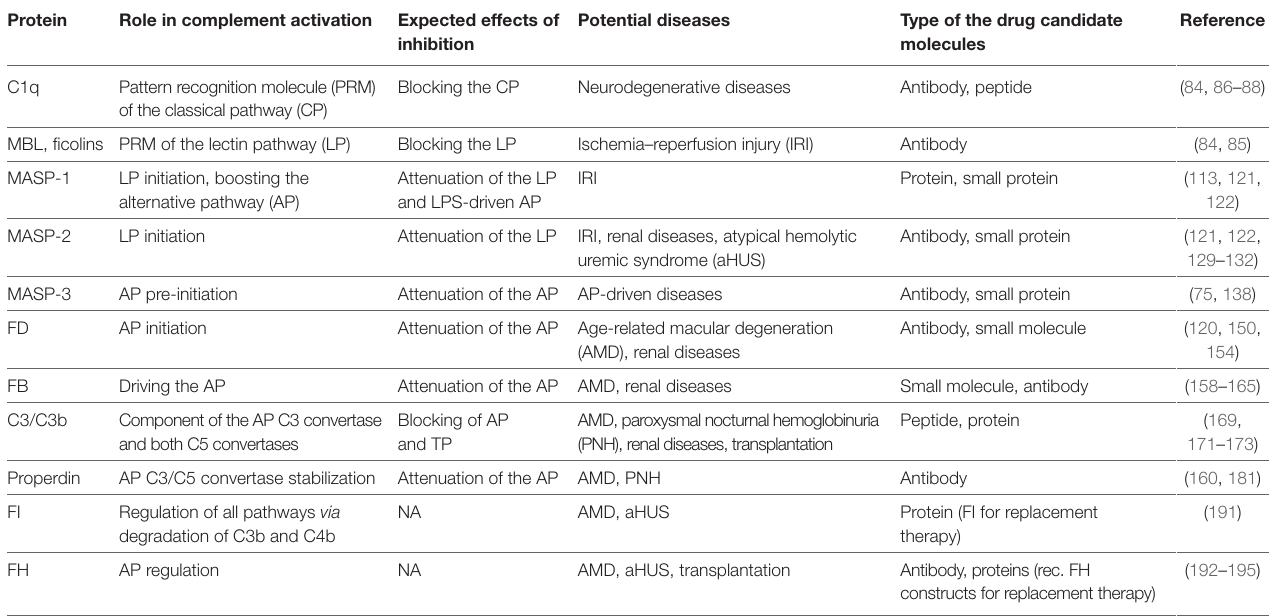
TABLe 1 | Potential drug targets of the complement system discussed in this